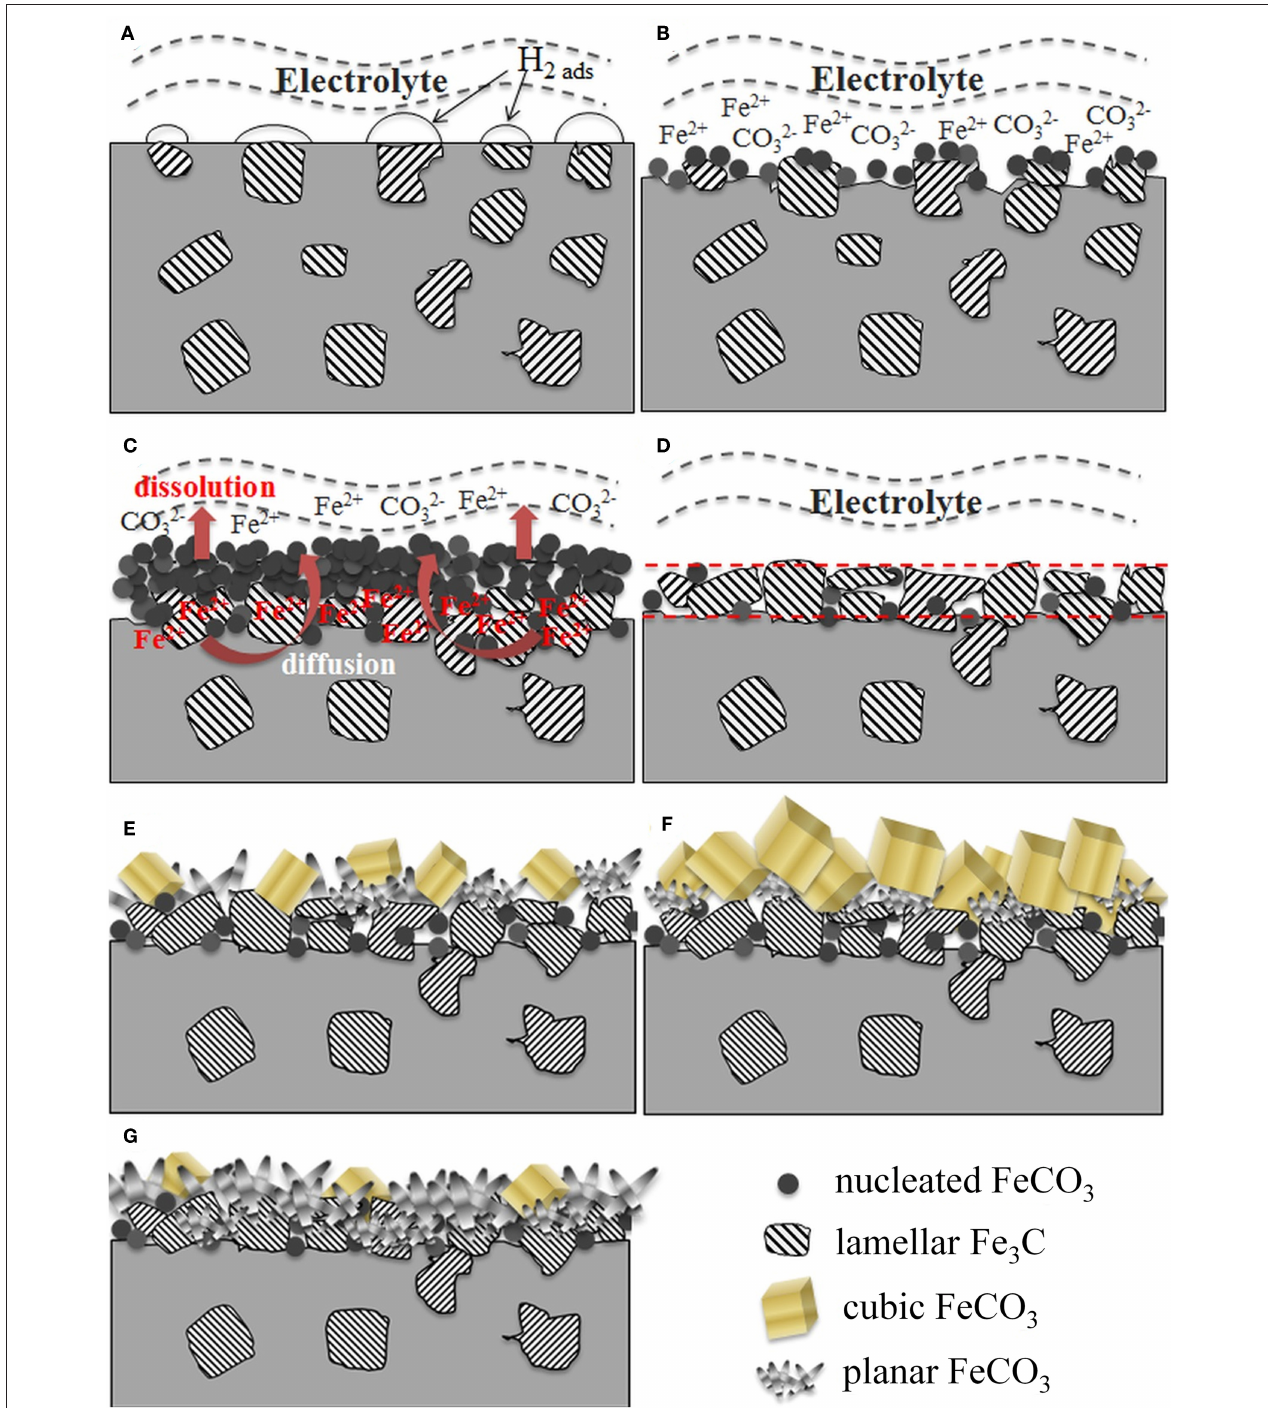
FIGURE 15 | Schematic diagrams showing the formation of corrosion scales on carbon steel immersed in CO 2 -saturated NaCl solutions as a function of time, temperature and salt concentration. (A) initial corrosion upon immersion; (B) early FeCO 3 nucleation; (C) accumulation of FeCO 3 ; (D) accumulation of Fe 3 C; (E) dual-layer formation; (F) growth of cubic FeCO 3 in outer layer; (G) compact inner layer with planar FeCO 3 .